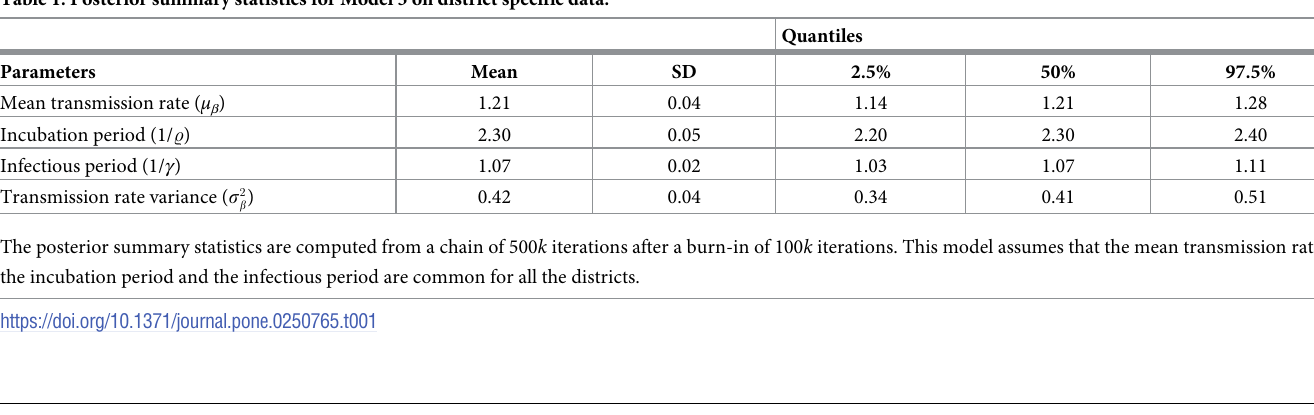
Table 1. Posterior summary statistics for Model 3 on district specific data.